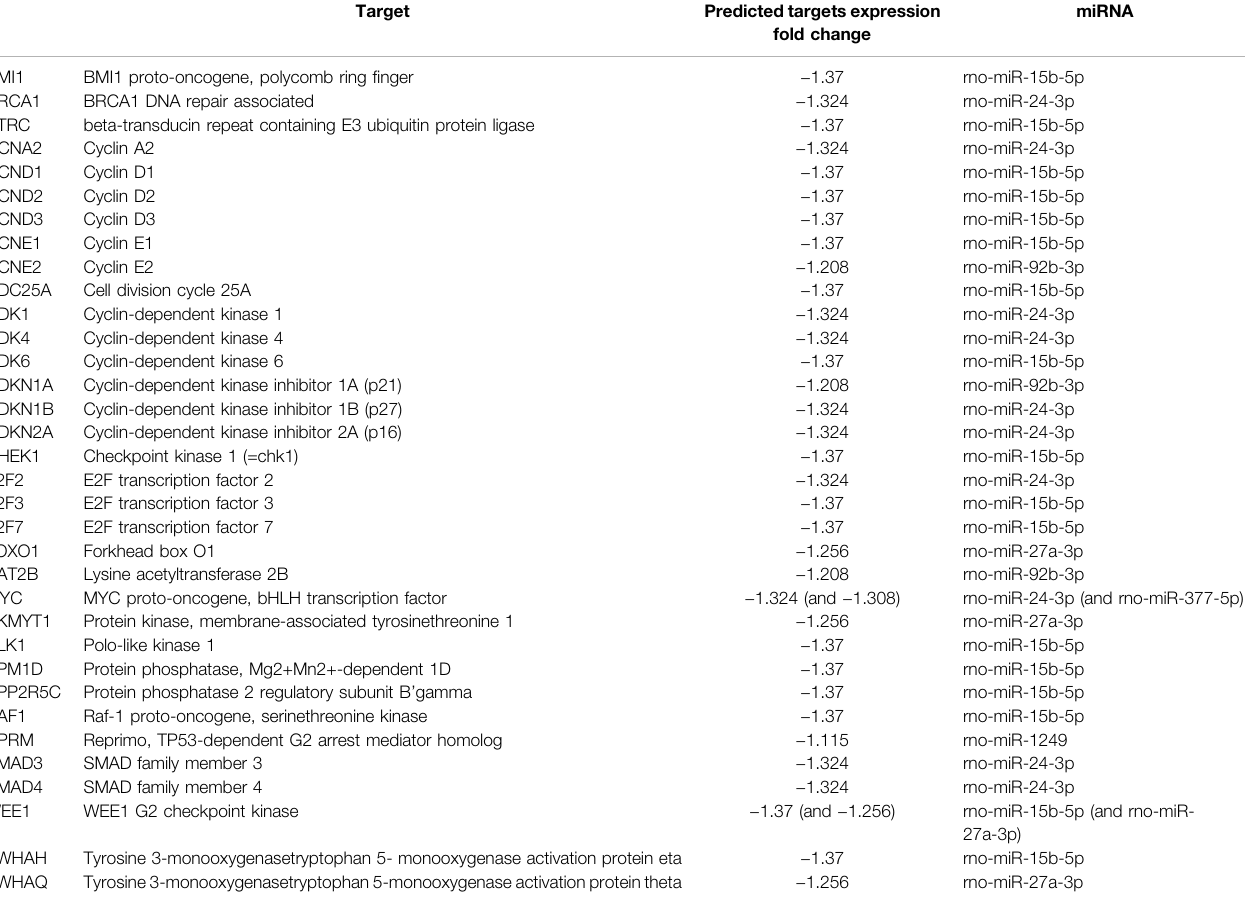
TABLE 1 | Predicted targets involved with cell cycle regulation (and its expr fold change) of miRNAs in adipocyte-derived EVPs impacted by aging. Target Predicted targets expression fold